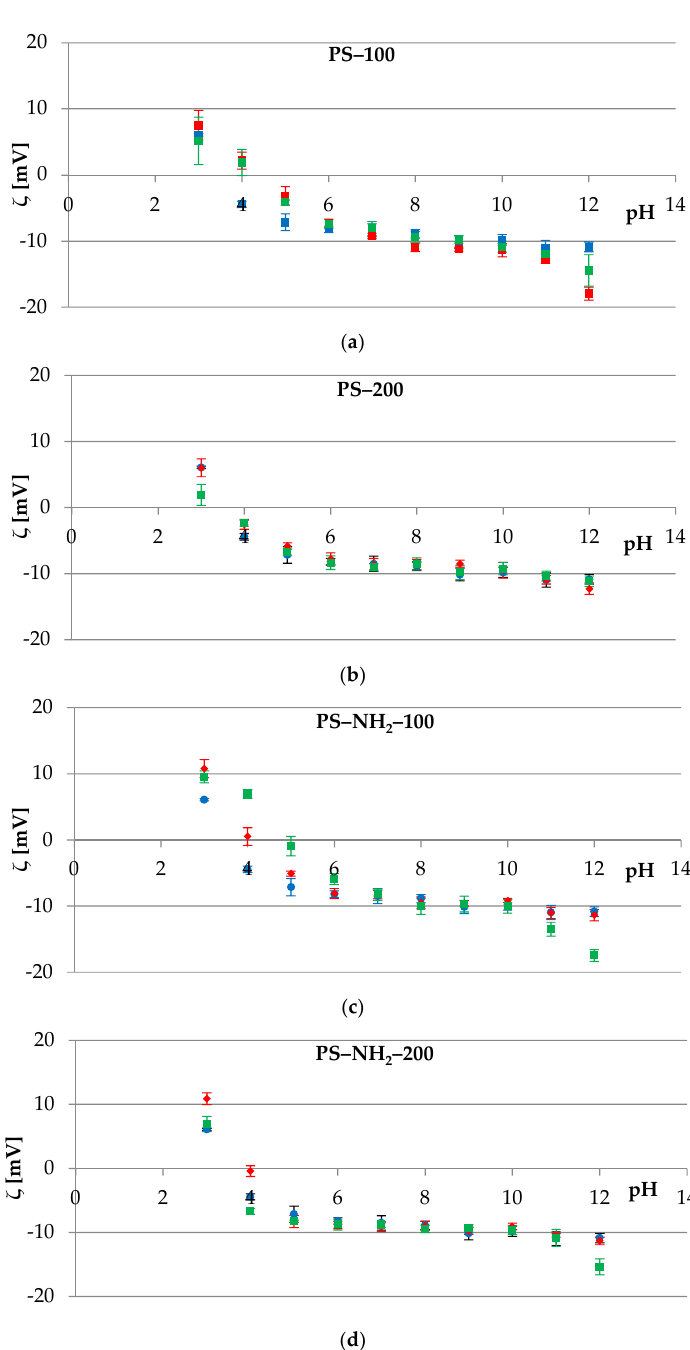
Figure 5. Zeta potential of the erythrocytes’ cell membranes as a function of the pH of the electrolyte solution. The parameter was measured immediately ( ● ), after 1 h ( ♦ ), and 3 h ( ■ ) of exposing the sample to the polymer: ( a ) PS–100, ( b ) PS–200, ( c ) PS–NH 2 –100, and ( d ) PS–NH 2 –200.